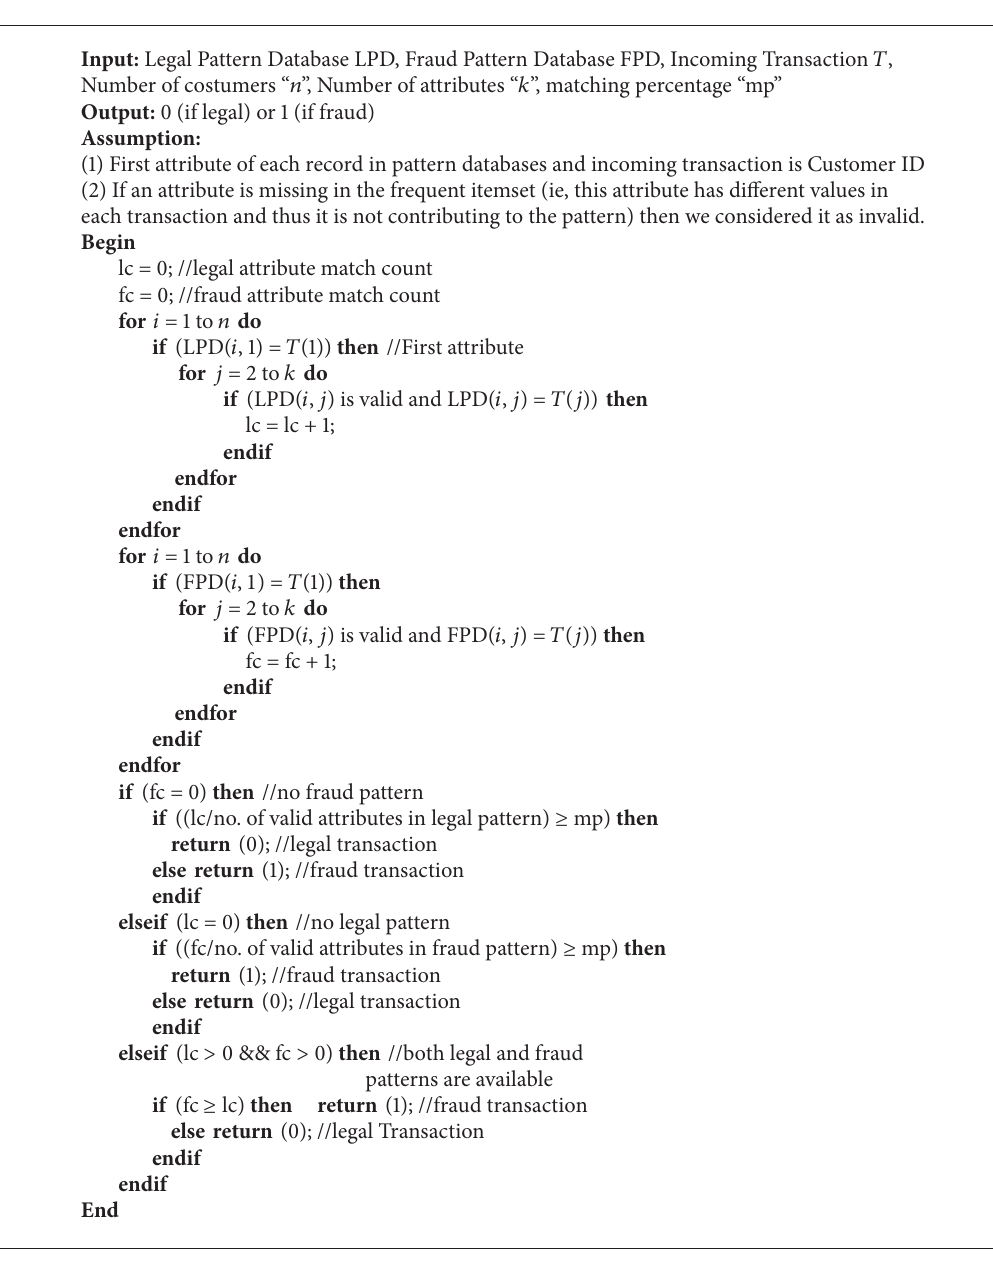
Algorithm 2: Testing